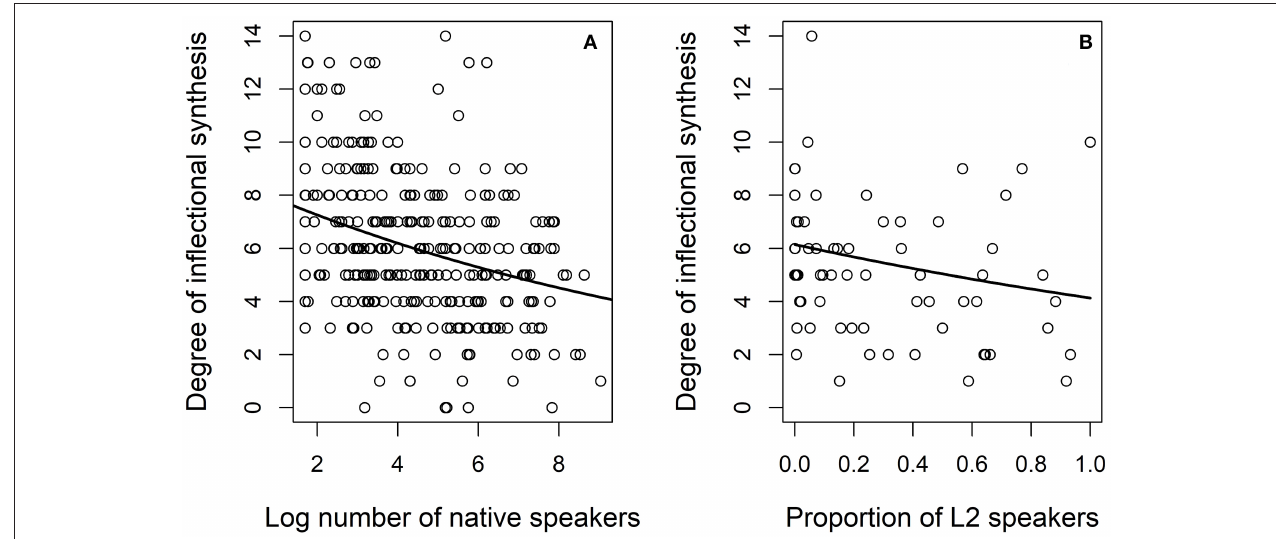
FIGURE 6 | Degree of inflectional synthesis as a function of log number of speakers on the left (A) and for the proportion of L2 speakers on the right (B)